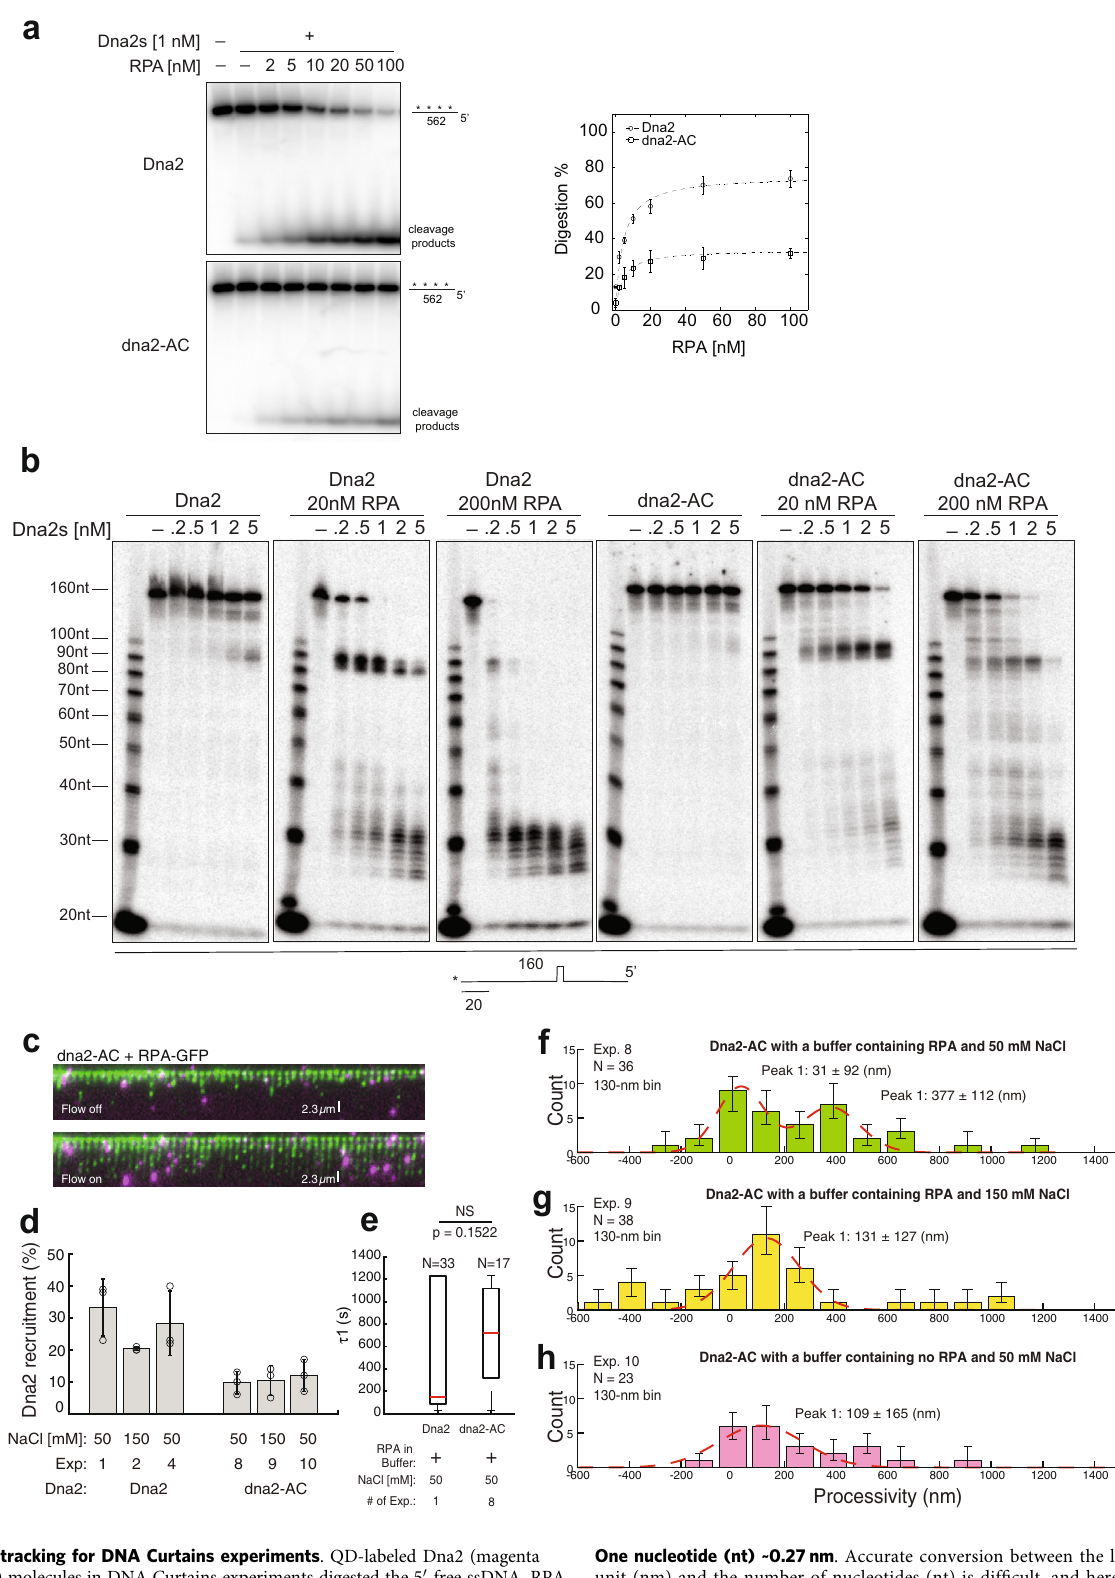
Image tracking for DNA Curtains experiments . QD-labeled Dna2 (magenta puncta) molecules in DNA Curtains experiments digested the 5 ′ -free ssDNA – RPA complexes. Image analysis was performed using open-source image-processing software ImageJ (Version: 2.0.0-rc-59/1.51k, http://imagej.net/Contributors). A particle-tracking script: “ Speckle TrackerJ (version: 0.87 built:10/11/2011) ” (http:// athena.physics.lehigh.edu/speckletrackerj) was used to track the magenta puncta image of Dna2. “ Diffusing_ spots ” model was chosen for tracking, and “ Gaus- sian_ fi t ” was chosen for 2D-Gaussian fi tting.